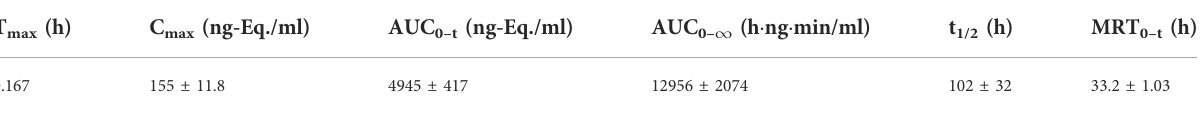
TABLE 9 Plasma pharmacokinetic parameters examined based on total radioactivity following a single intramuscular administration of 100 µg/ 300 μ Ci/kg of [3H]BPC157 in rats (mean ± SD, n = 6). T max